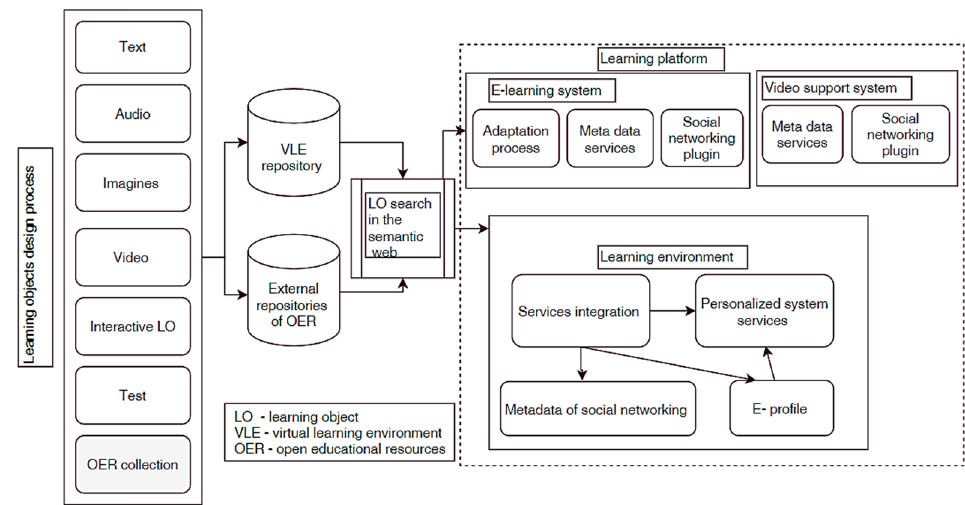
Figure 5. ELO design, search and adaptation.